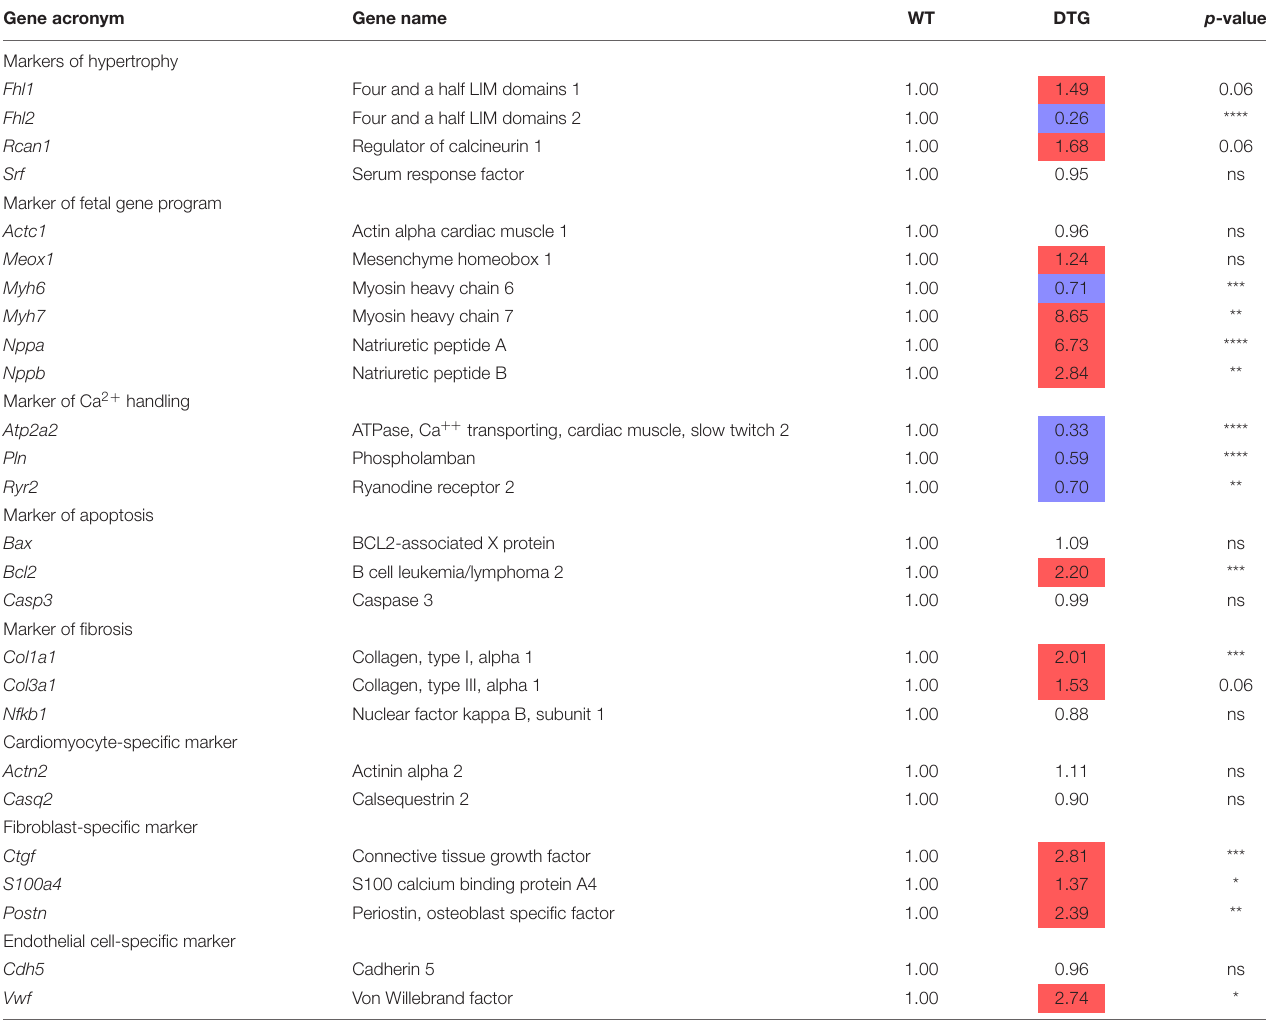
TABLE 1 | Gene expression analysis in DTG and WT